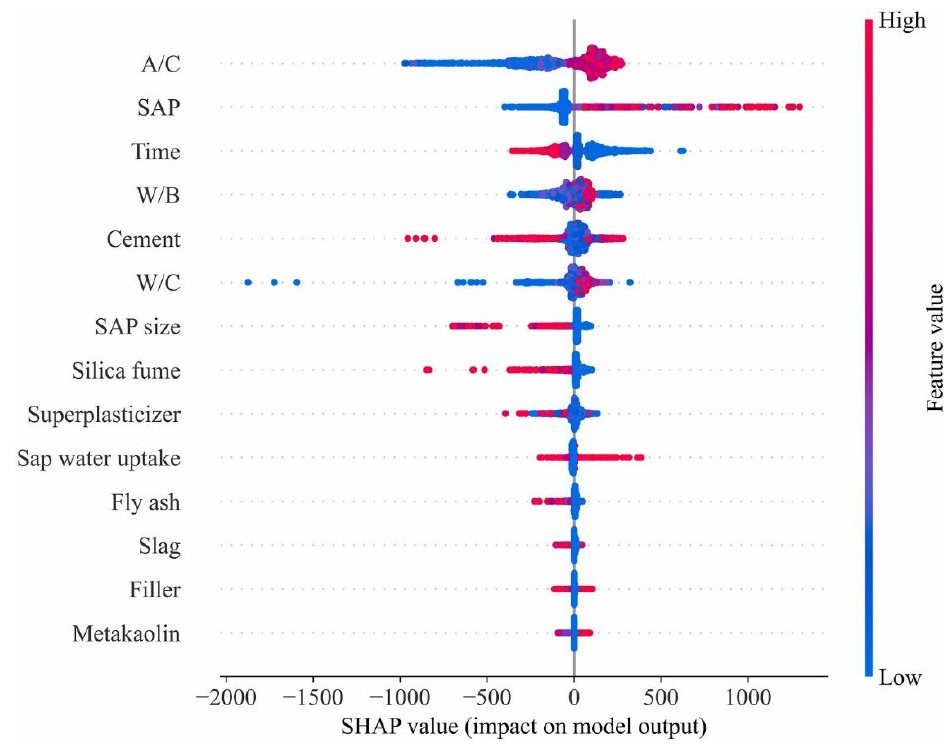
Figure 12. Feature importance analysis using the SHAP library in Python code.